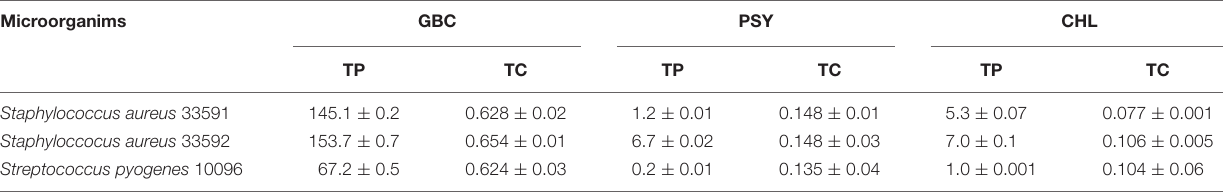
TABLE 3 | Biochemical composition of biofilms treated with psychorubrin and chloramphenicol. Microorganims